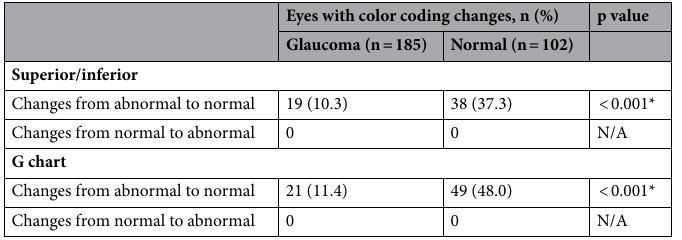
Table 6. Color coding changes in glaucomatous and normal eyes after using long axial length database. CI Confidence Interval, N/A Not Applicable. *Statistical significance shown at p <